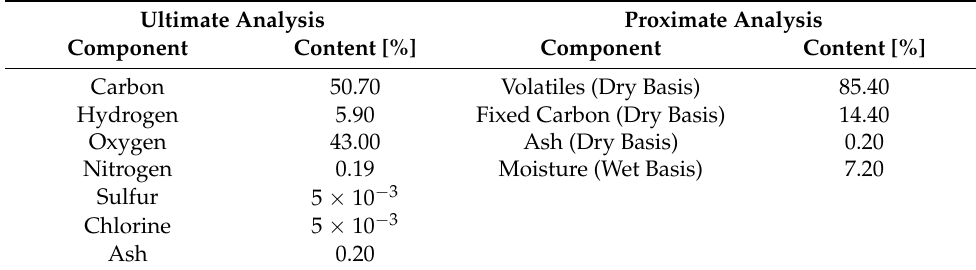
Table 1. Ultimate and proximate analysis of fuel used [29].